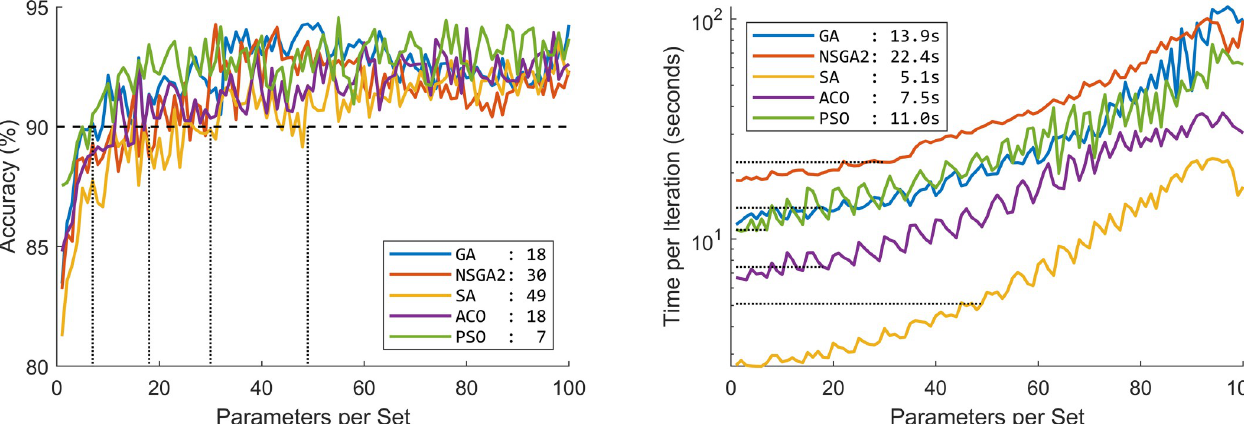
Fig 3. Performance of the five evolutionary algorithms (EA) in terms of (a) percentage accuracy and (b) optimization speed. The values in the legend of panel (a) show the minimum number of parameters required to achieve minimum 90% accuracy. The values in the legend of panel (b) show the minimum optimization speed to achieve minimum 90% accuracy based on panel (a). GA: Genetic algorithm; NSGA2: Nondominated sorting genetic algorithm II; ACO: Ant colony optimization; SA: Simulated annealing; PSO: Particle swarm optimization.